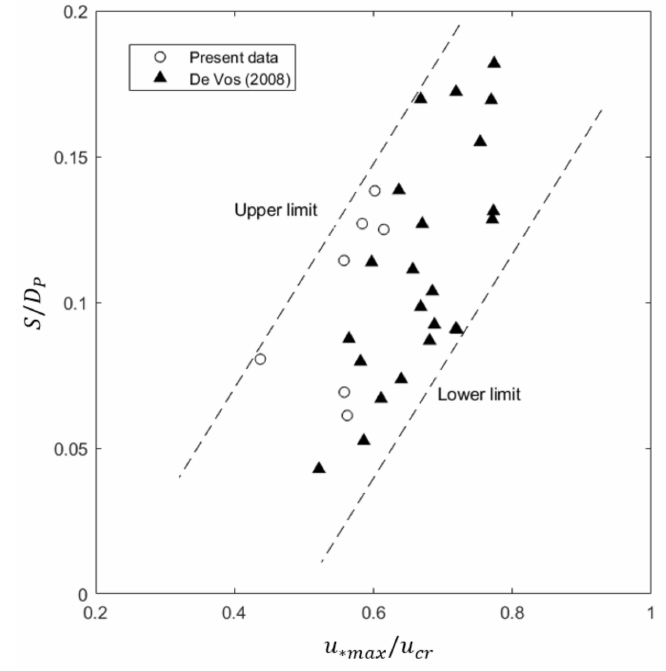
Figure 15. Relation between S / D P and u ∗ max / u cr after 3000